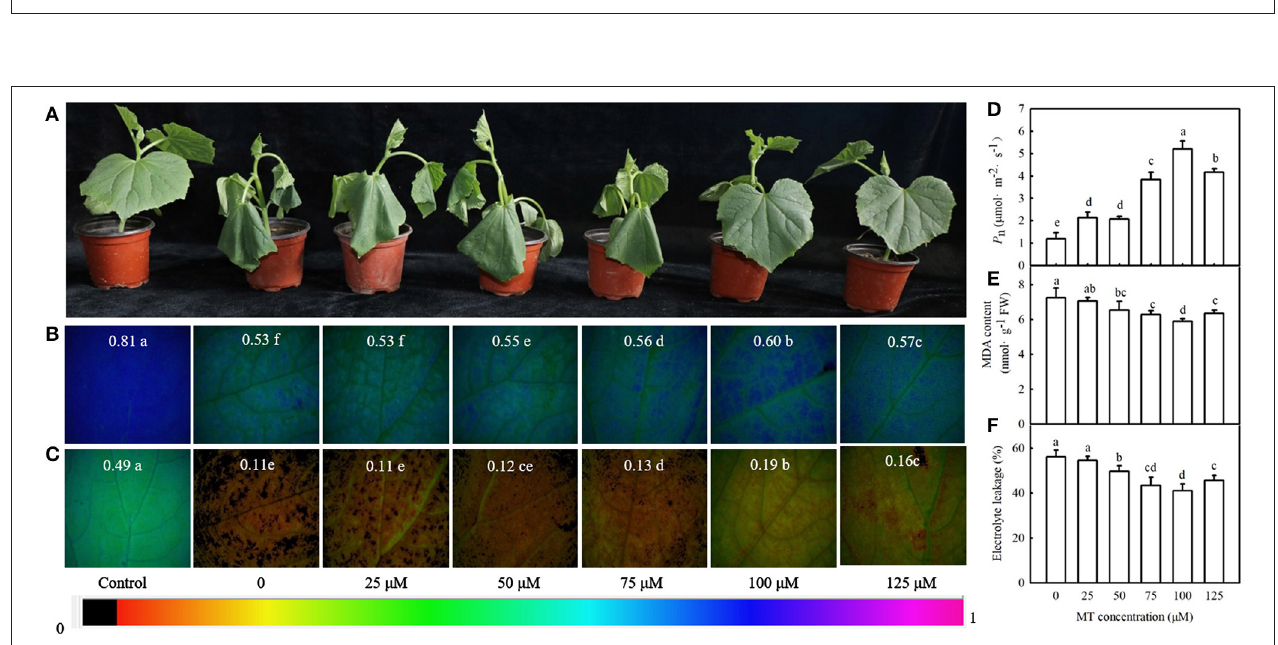
FIGURE 3 | Effects of MT on cold tolerance of cucumber seedlings under cold stress. (A) Seedling phenotype; (B) images of F v / F m , (C) Φ PSII ; (D) P n . Three-leaf stage seedlings were foliar sprayed with MT (0, 25, 50, 75, 100, or 125 µ M) for 24h and then were exposed to 5 ◦ C for 24h. (E) MDA content; (F) EL rate. Seedlings were foliar sprayed with MT (0, 25, 50, 75, 100, or 125 µ M) for 24h and then were exposed to 5 ◦ C for 72h. Data are represented as mean ± SD ( n = 3). Different letters indicate a significant difference between samples according to Duncan’s new multiple range test ( p < 0.05).